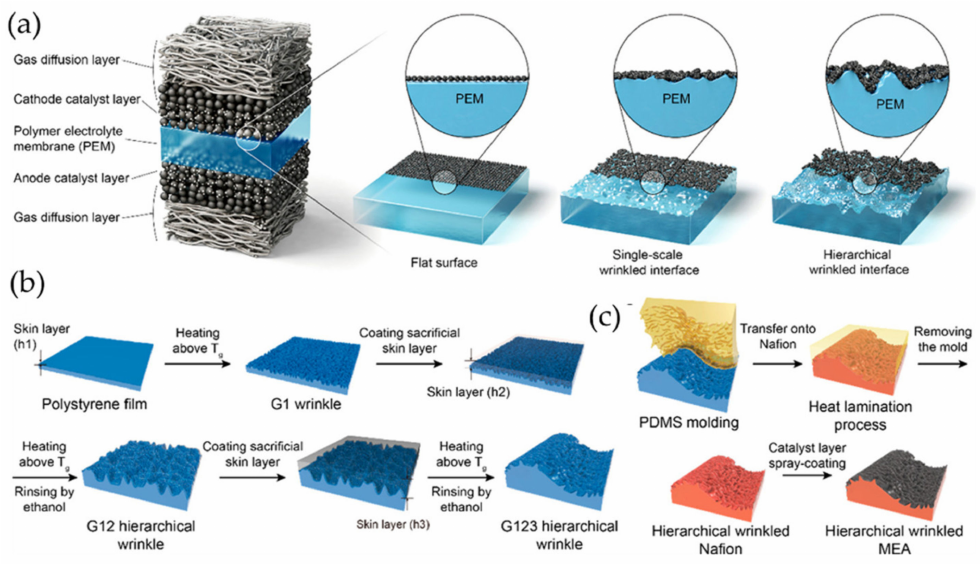
Figure 15. Schematic illustrations of hierarchical wrinkled PEM/CL fabrication. ( a ) The types of hierarchical wrinkled PEM/CL interfaces in PEMFC. ( b ) Fabrication of hierarchical wrinkles through repetitive heat-induced wrinkling processes and ( c ) Transfer of wrinkled hierarchical structures to Nafion membrane by thermal lamination and subsequent CL coating. Reproduced permission from with reference [66]. Copyright 2022, American Chemical Society